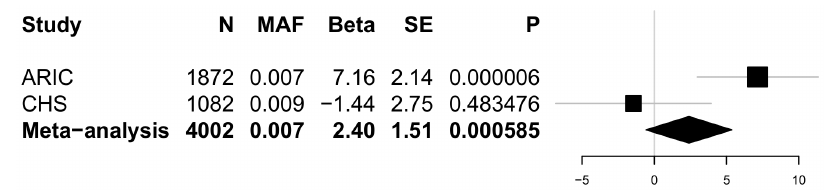
Figure 3. Forest plot for rs12806040 in relation to DBP. The beta estimate and standard error are reported from the unconditional weighted analyses. P-values are reported from unconditional unweighted analyses.